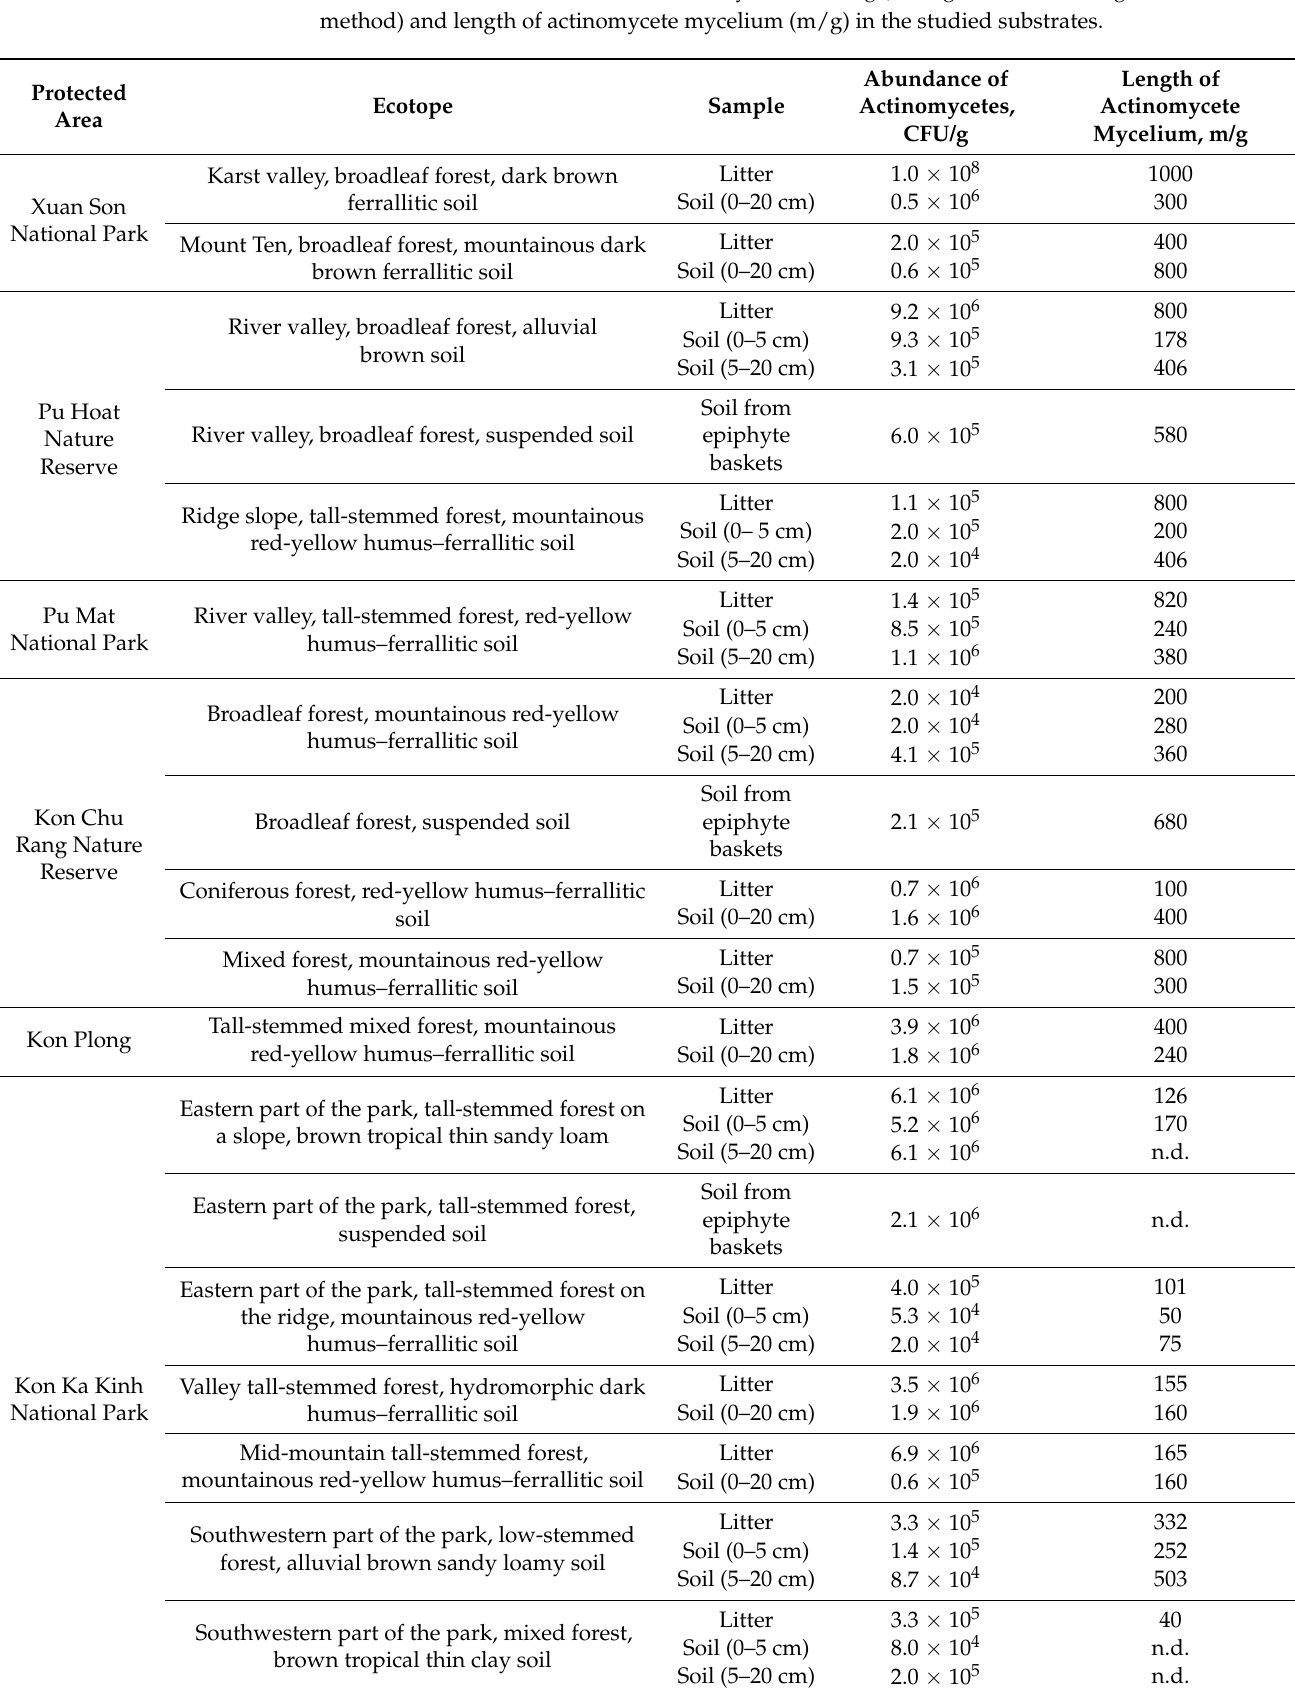
Table 2. The number of cultivated actinomycetes, CFU/g (average value according to the inoculation method) and length of actinomycete mycelium (m/g) in the studied